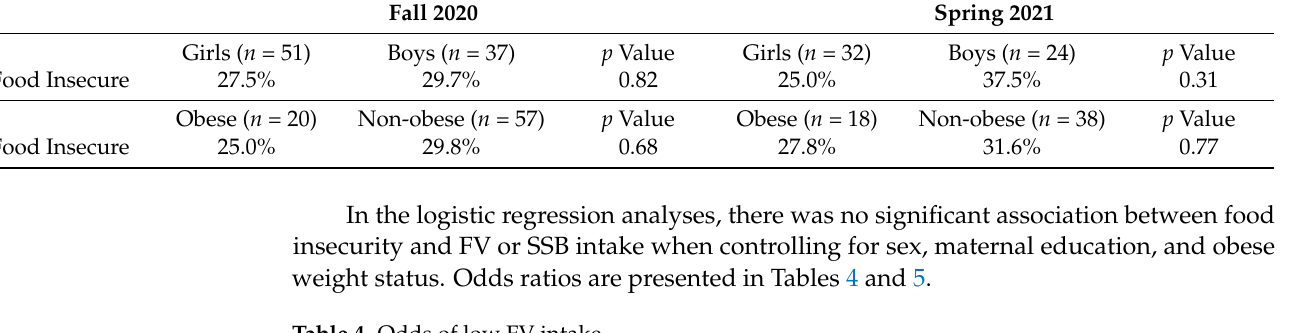
Table 4. Odds of low FV intake.